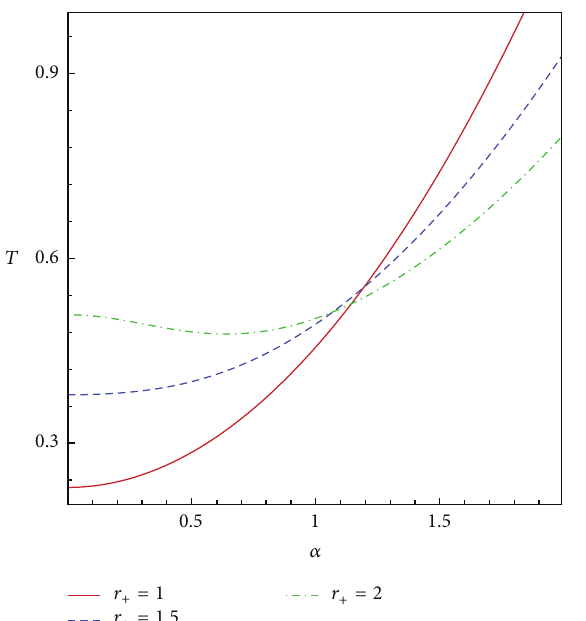
Figure 5: The behavior of 𝑇 versus 𝛼 with 𝑙 = 𝑏 = 1 , 𝑞 = 0.8 , Ξ = 1.25 , 𝑛 = 5 , and 𝛽 = 2 .